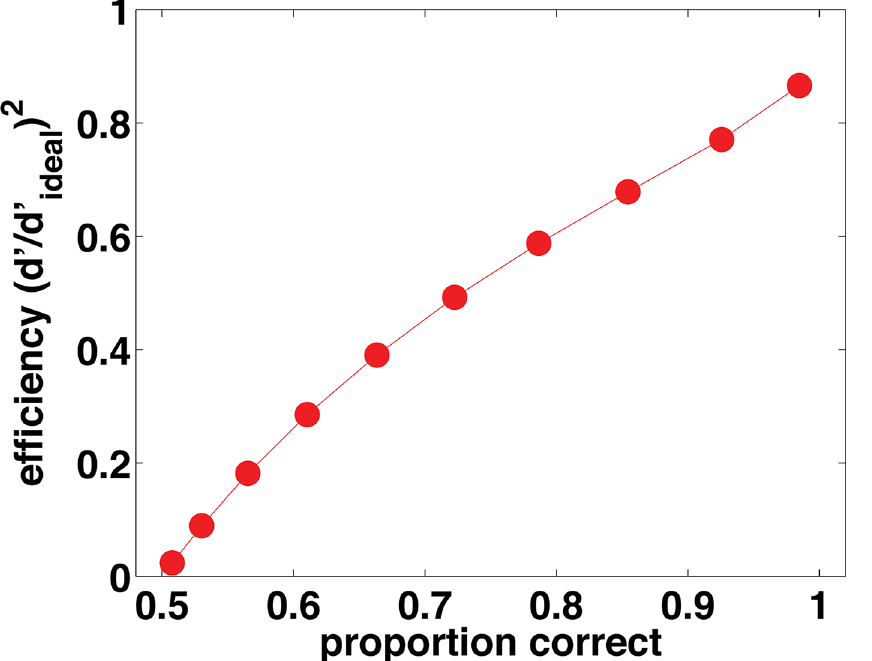
Fig 2. Efficiency of posterior probability matching as a function of proportion